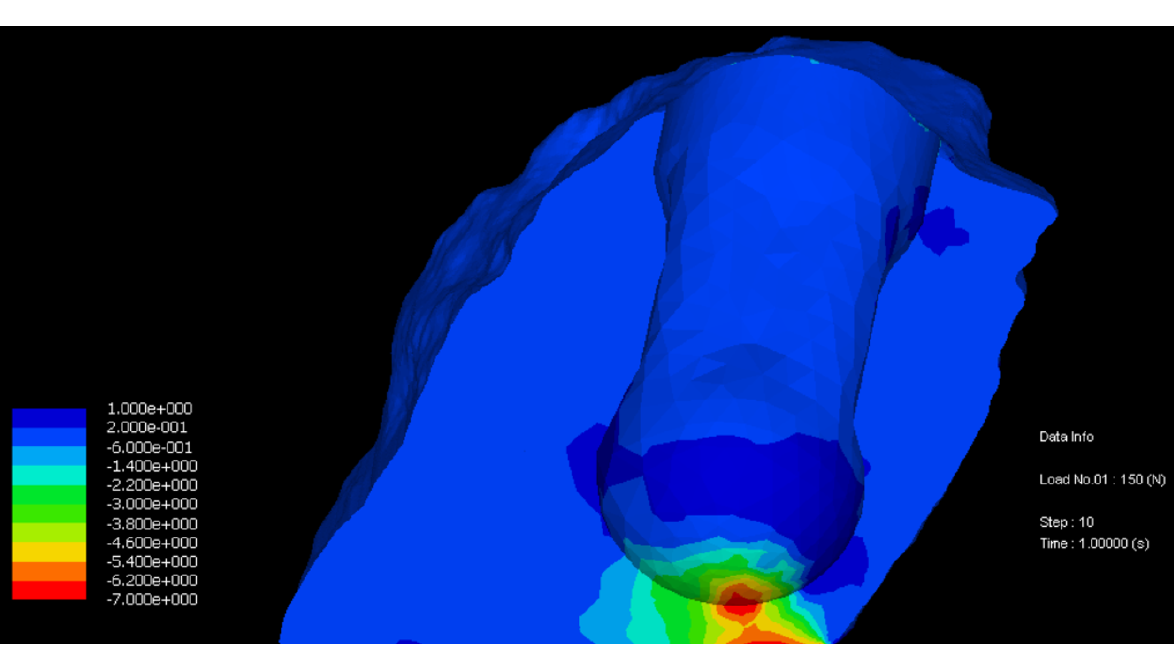
Figure 7. The minimum principal stress of the bone material at the peri-implant area in MPa for the homogeneous variant of the implant. The maximum value of compressive stress at this section is 7.0 MPa for an axial load of 150 N. The value is smaller as compared to Fig. 8 because the implant is much stiffer and transfers much less load into the surrounding bone.